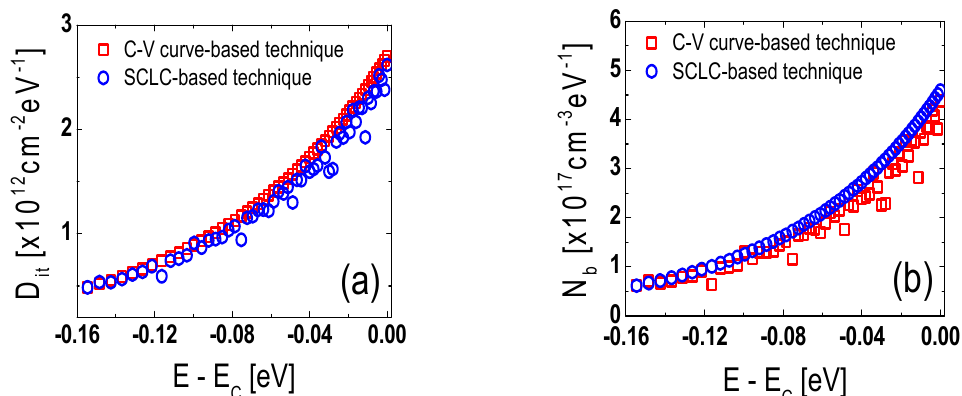
Figure 9. Energy distributions of ( a ) D it and ( b ) N b extracted using the technique based on the low-frequency C – V curve and the SCLC-based technique.